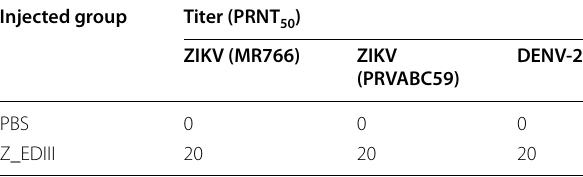
Table 1 Level of neutralizing antibodies against two ZIKV strains and a dengue virus (DENV‑2) strain in immunized mice Injected